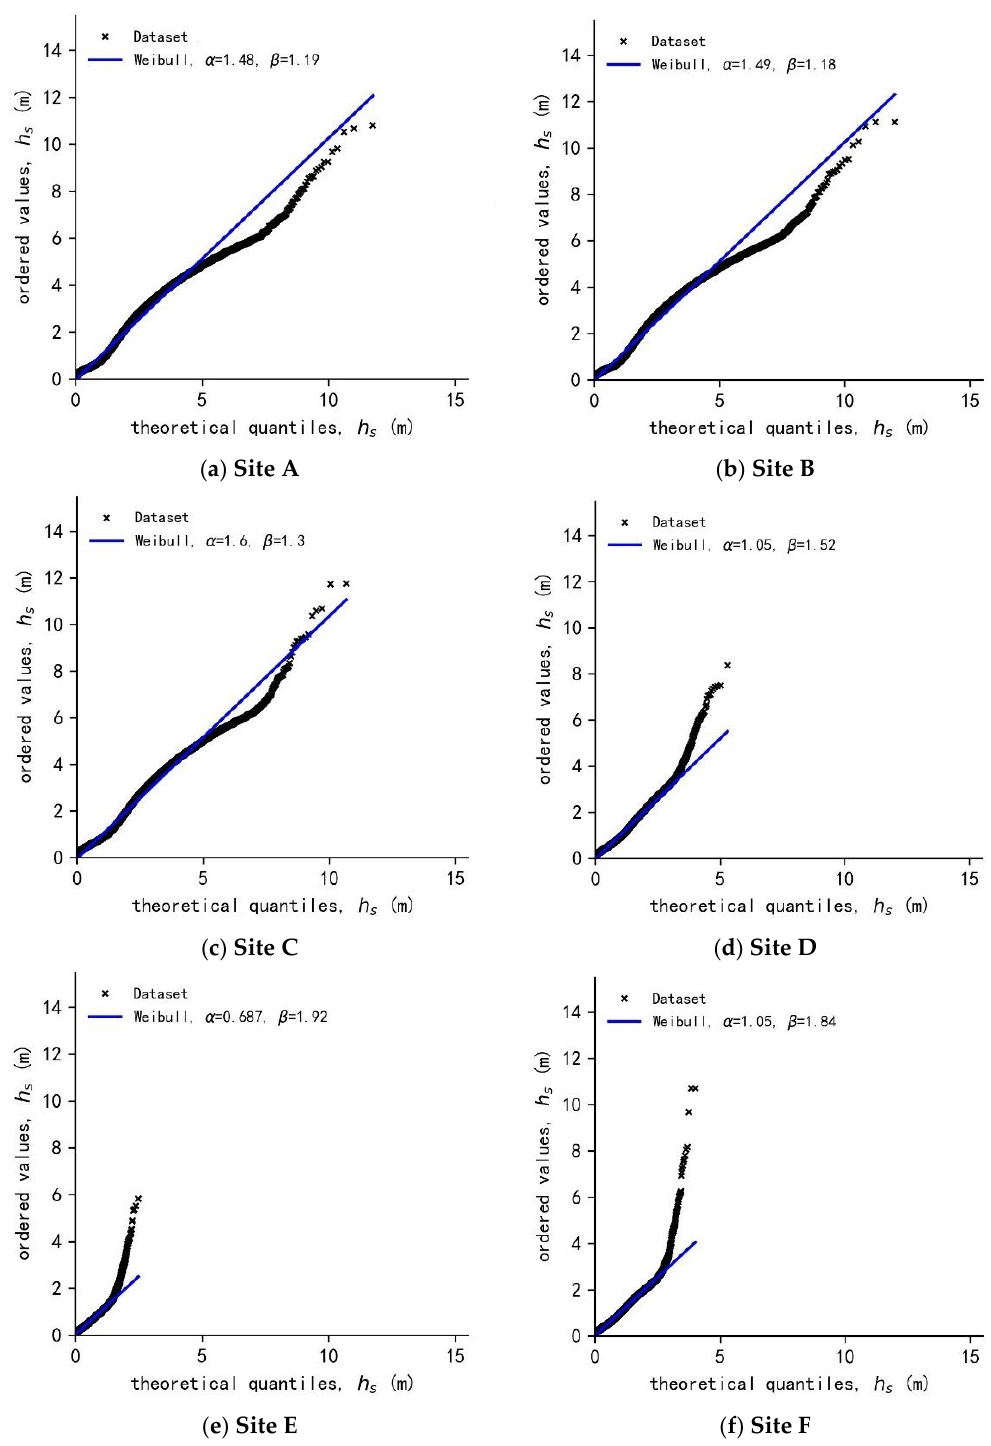
Figure 28. Fitting results of significant wave heights using two-parameter Weibull distribution of sea-state parameters at reference sites in the Xisha Islands.